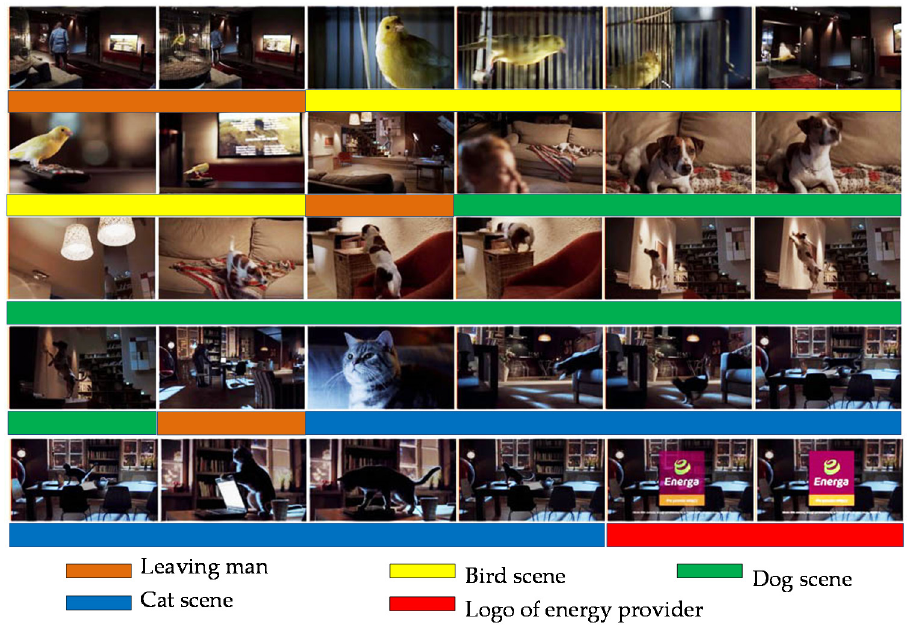
Figure 1. Frame sequence for Energa media message.